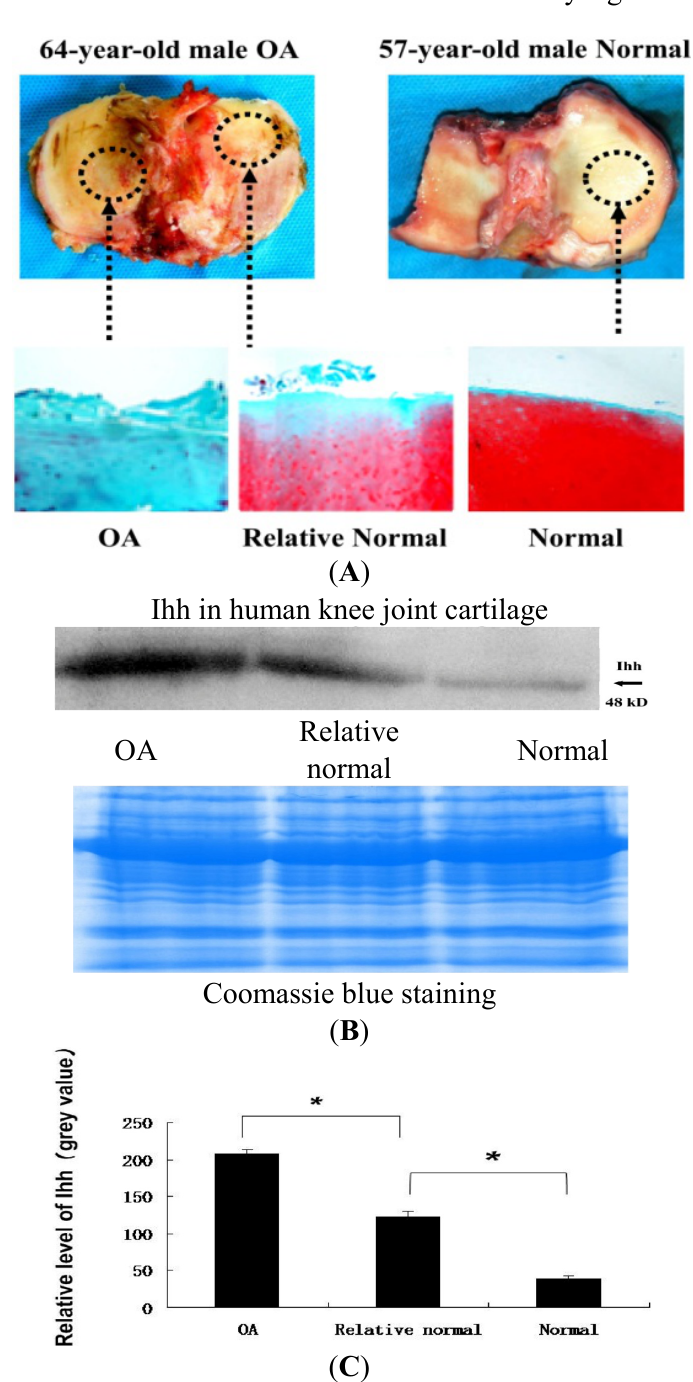
Figure 3. OA cartilage damage is associated with the increase of Ihh expression determined by western blot in cartilage. ( A ) Representative Safranin O stain from OA cartilage, adjacent relative normal and normal control cartilage, magnification 10×; ( B ) Western blot demonstrates the level of Ihh protein from OA, relative normal and normal cartilages, arguing that the increase of Ihh is associated with the severity of cartilage damage. Coomassie Blue stain was used to confirm equal loading; ( C ) Density of the Ihh band from Western blot was semi-quantified using the Image Analysis Software (Image Lab 3.0, Bio-Rad, Hercules, CA, USA). Bar graphs show the average with SD; n = 3; * p < 0.001; p value of less than 0.05 was considered statistically